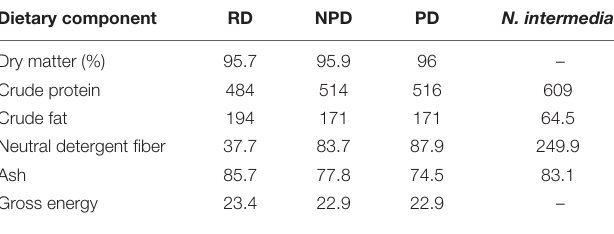
TABLE 2 | Proximate composition [g kg − 1 dry matter (DM)] and energy content (MJ kg − 1 DM) of the reference diet (RD), non-preconditioned diet (NPD), preconditioned (heat-processed) diet (PD), and Neurospora intermedia fungal